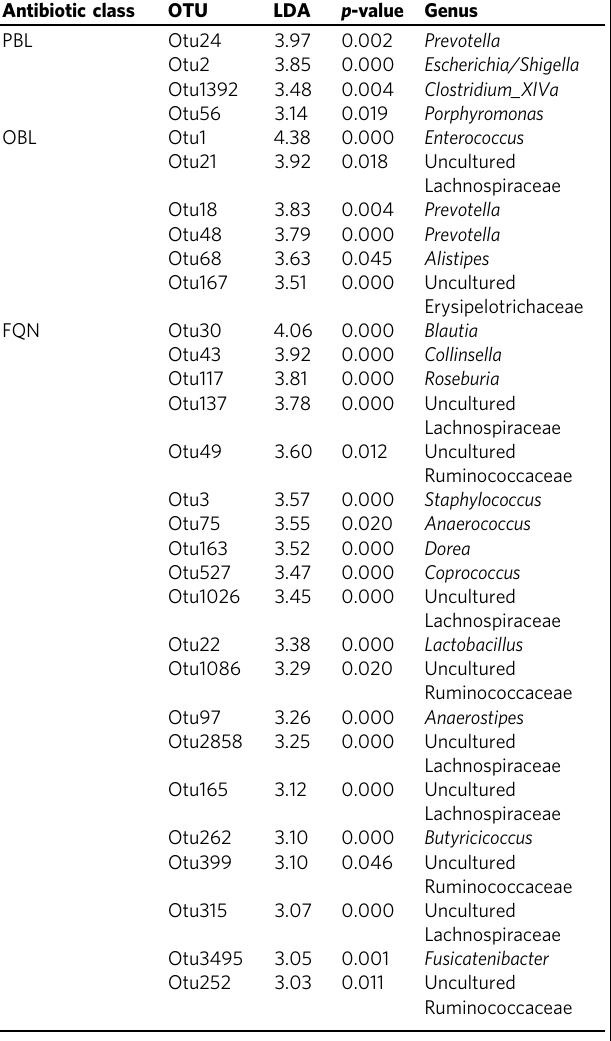
The microbiota of patients treated with PBLs ( n = 194), OBLs ( n = 133), and FQNs ( n = 63) was compared at D6 to identify the class-speci fi c impact of broad-spectrum antibiotic treatment. Distinctly abundant OTUs associated with each timepoint were identi fi ed using linear discriminant analysis effect size (LEfSe, LDA>3.0). D6: rectal swab collected ~6 days after initiation and at the end of antibiotic treatment. PBL: penicillin + beta-lactamase inhibitor. OBL: otherbeta-lactamaseantibiotics.FQN: fl uoroquinolones.LDA:lineardiscriminantanalysisscore. OTU: operational taxonomic